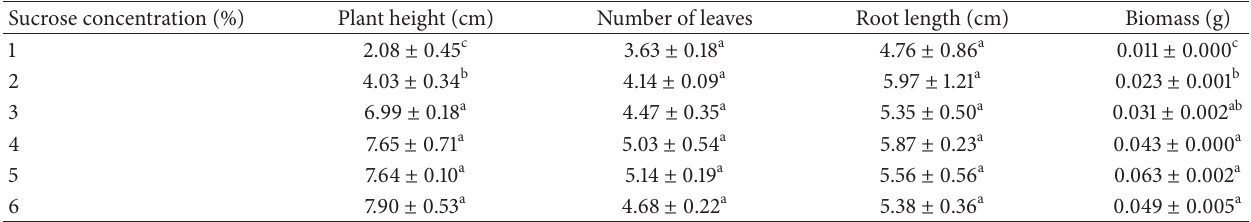
Table 4: Mean values of growth parameters of Bambara groundnut plantlets on 1/2 MS containing different concentrations of sucrose. Sucrose concentration